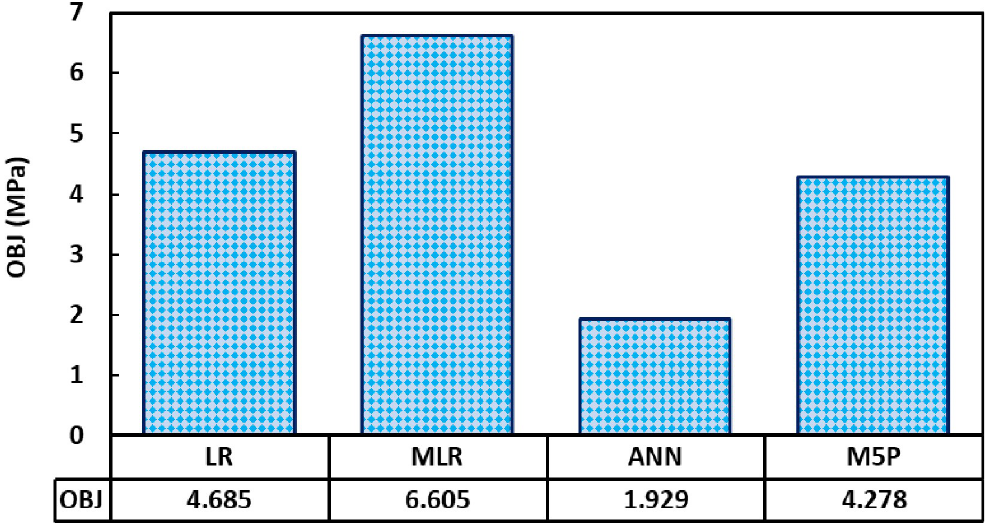
Fig 14. Barchart of OBJ values of the models used.